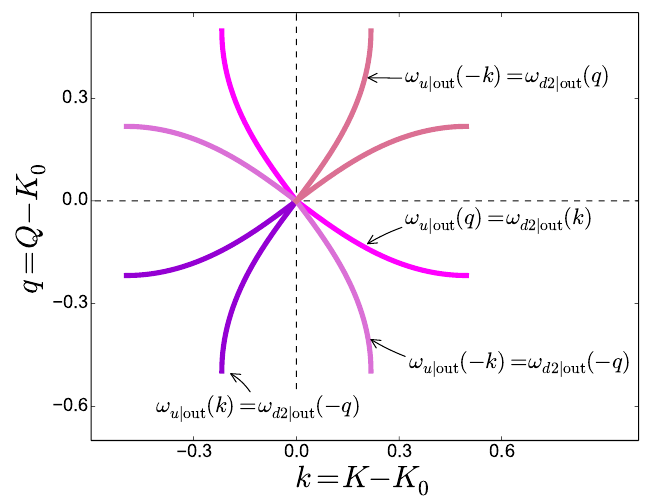
Figure 8: Momentum space correlation lines for the u | out- d 2 | out signal in a non-adiabatic case = 0.5 and M = 4. The correlation line corresponding for a flat profile configuration with M u d ( k ) = ω ( − q ) is already present in the adiabatic regime (see the right plot of Fig. to ω u | out d 2 | out 4). The lines of identical colors are obtained one from the other by an exchange of k and q . The same pattern arises in situ . The momenta are expressed in units of ξ − 1 u